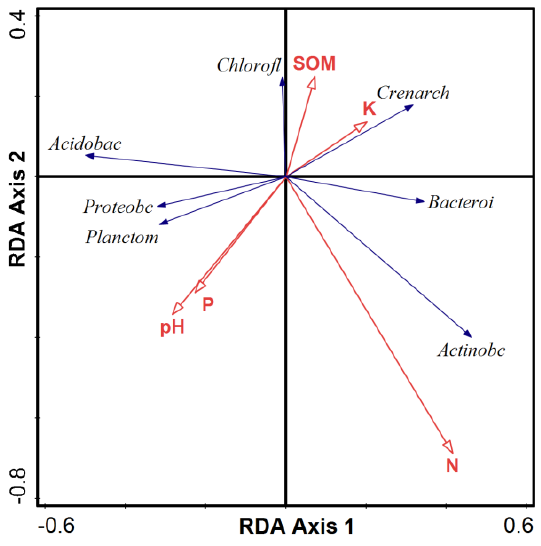
Figure 5. Redundancy analysis (RDA) for seven primary soil bacterial communities ( Proteobacteria, Actinobacteria, Acidobacteria, Crenarchaeota, Chloroflexi, Bacteroidetes, Planctomycetes ) from all samples associated with environmental variables (pH, SOM, available P, available N and available K).